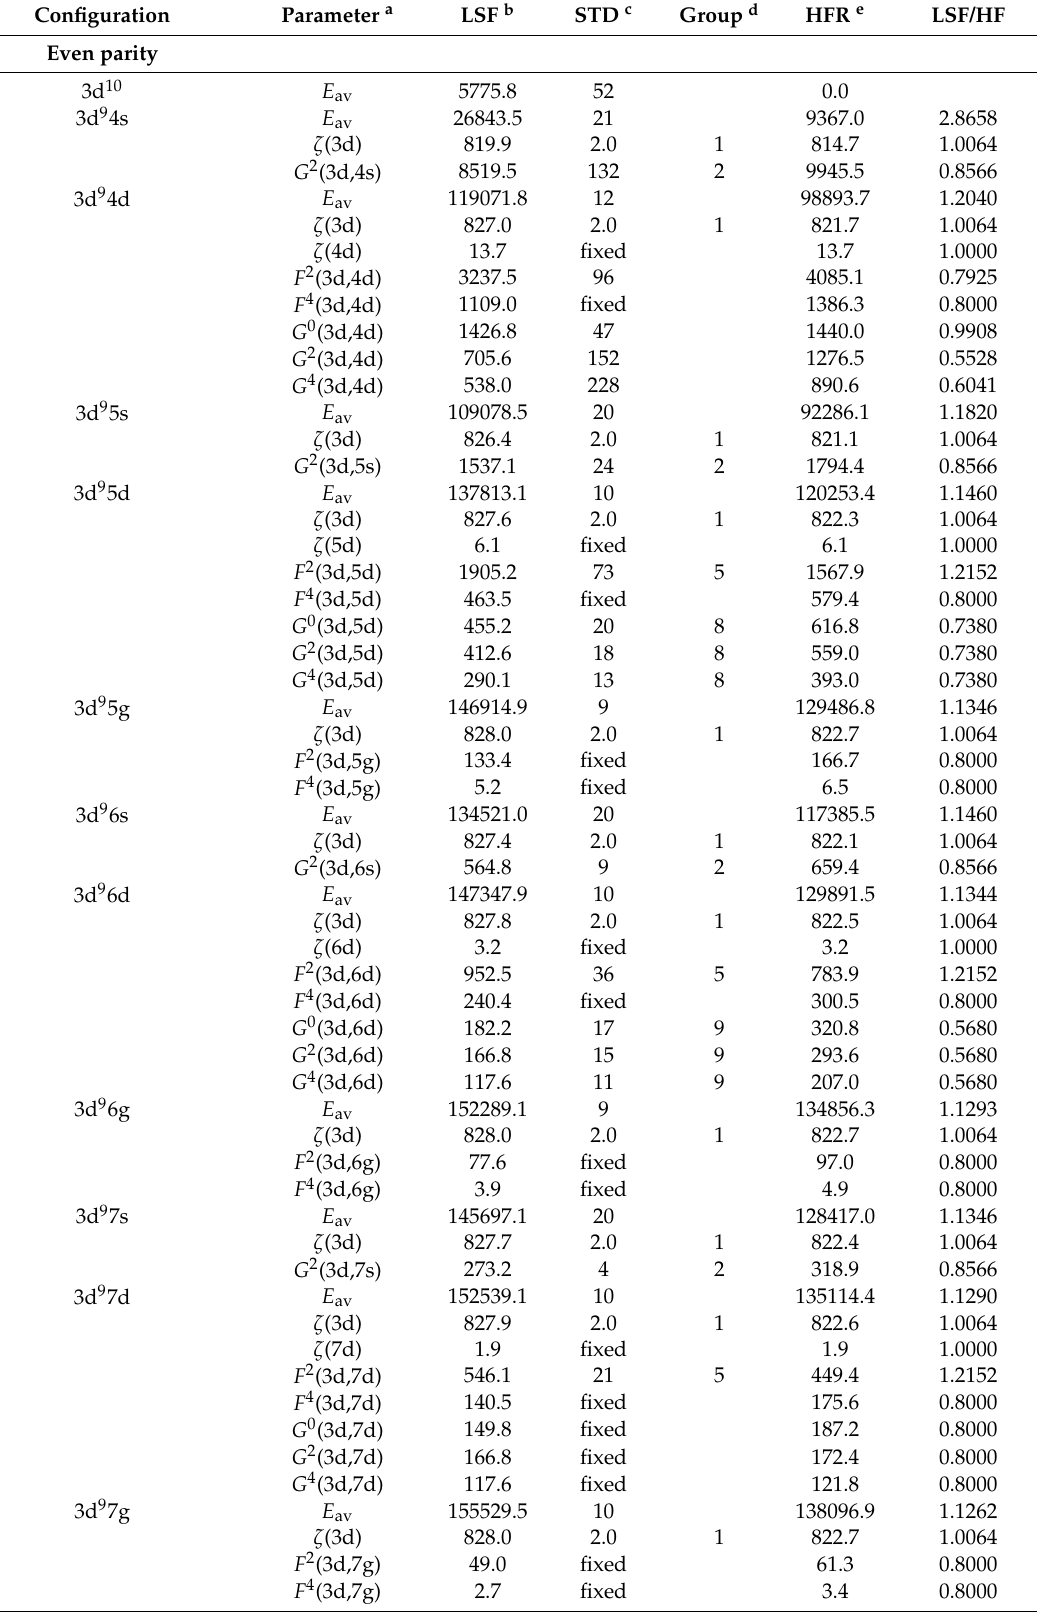
Table A3. Least-squares fitting parameters for Cu